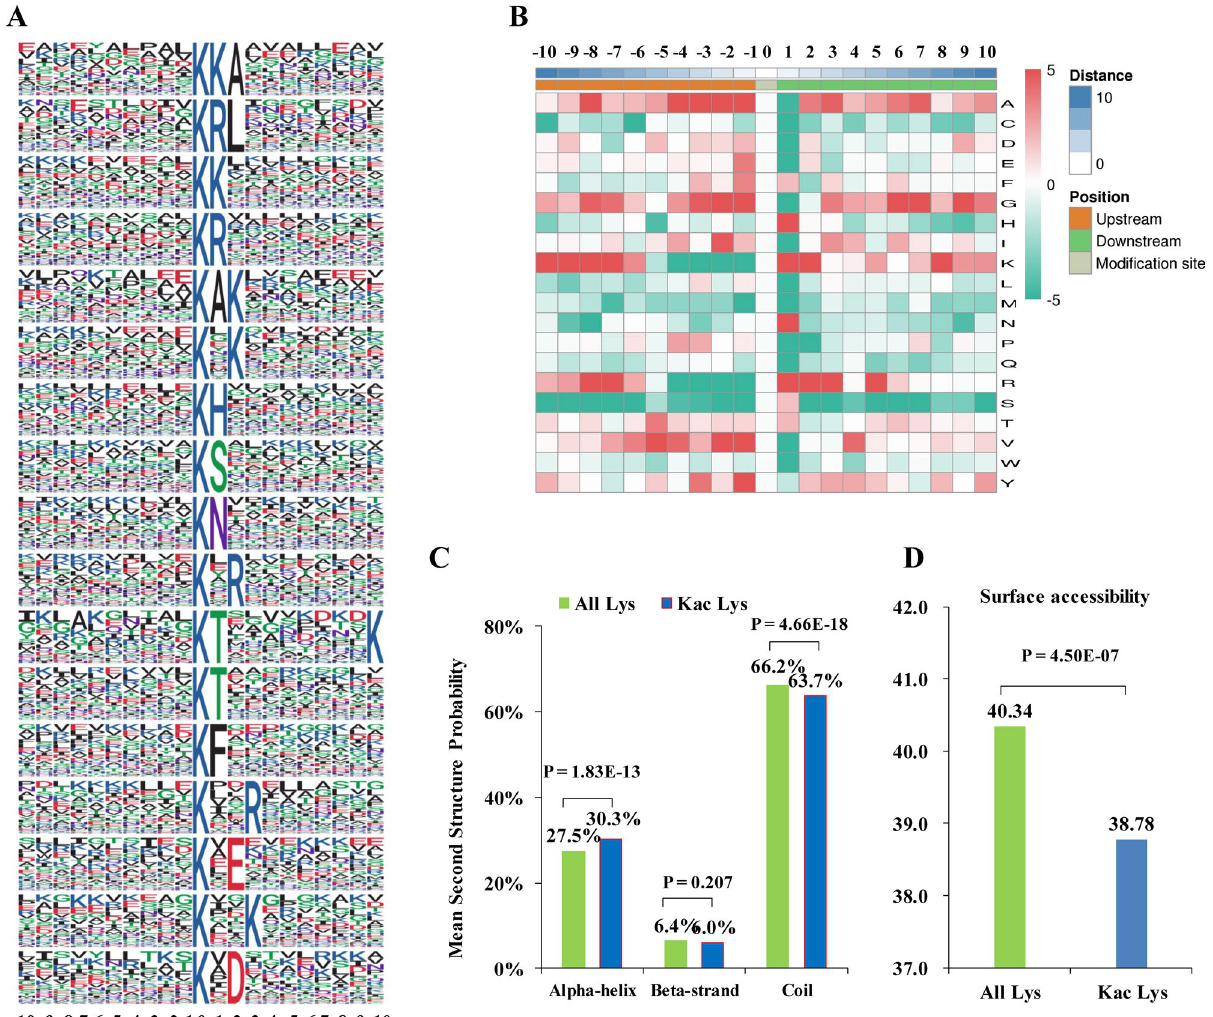
Figure 2. Motif analyses of the detected Kac sites. ( A ) Acetylation sequence motifs for amino acids around Kac sites (− 10 to + 10). The letter height represents the frequency of that amino acid residue at that position. The K in the middle position corresponds to the acetylated lysine. It was performed with motif-x (Version 1.2 10.05.06; https:// motif-x. med. harva rd. edu/ motif-x. html). ( B ) Heat map analysis of the amino acid compositions around the acetylated sites. Red indicates an amino acid that is significantly enriched, while green indicates an amino acid that is significantly reduced. It was performed with the “heatmap.2” function in the “gplots” R-package. ( C ) Secondary structure analysis of Kac peptides. ( D ) Predicted surface accessibility of Kac peptides. Secondary structure and surface accessibility analysis were performed using NetSurfP (version 2.0; http:// www. cbs. dtu. dk/ servi ces/ NetSu